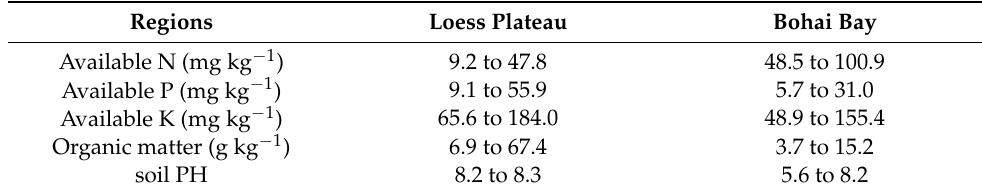
Table 1. Basic soil information at regional scale in apple planting regions of China’s Loess Plateau and Bohai Bay.